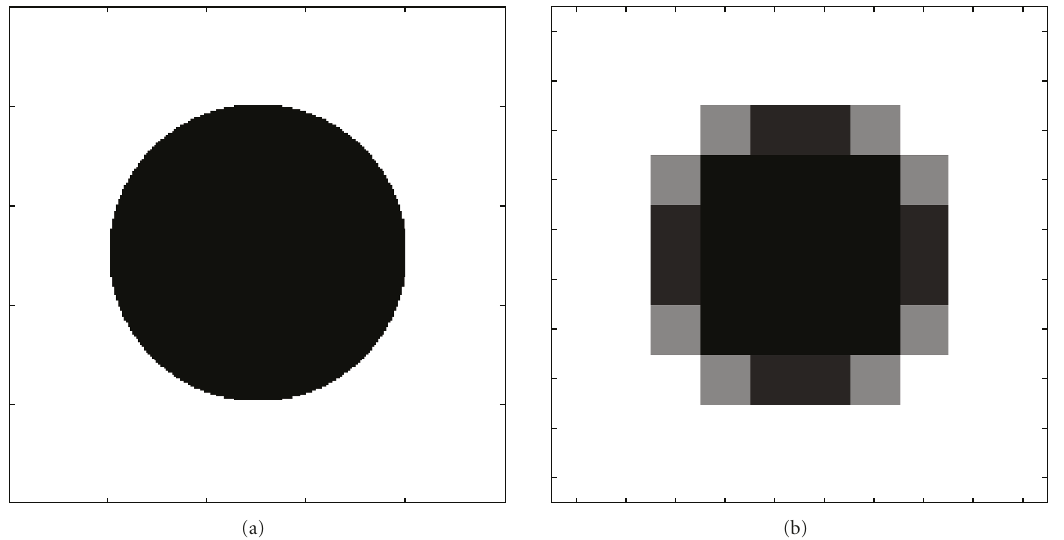
Figure 3: (a) A high resolution (uniform 0.02 mm voxels) binary mid-slice image of marker, (b) corresponding mid-slice at the MR acquisition resolution (uniform 0.5 mm